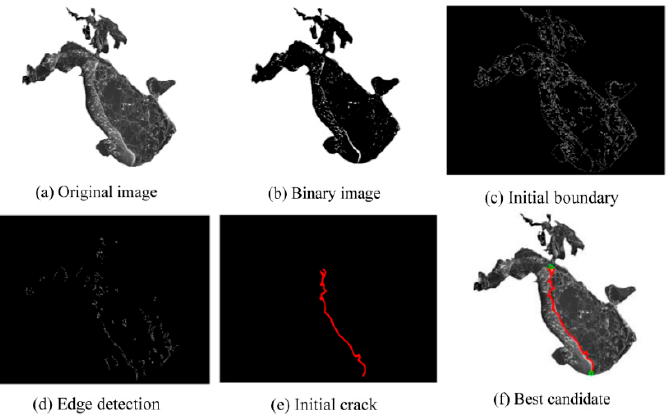
Figure 3. The extraction result of lake ice fracture. The Landsat OLI remote sensing data were ac- quired on December 8, 2018.